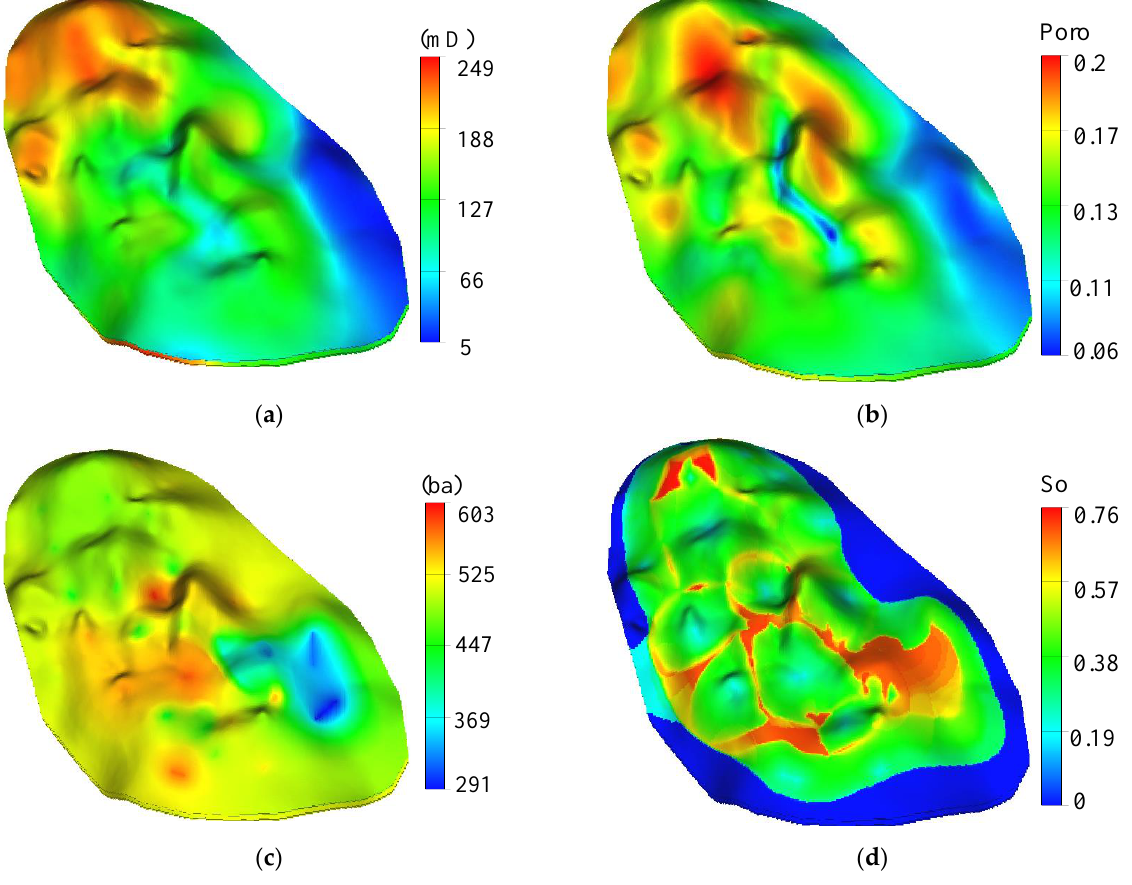
Figure 1. Basic properties of Baoshaceng reservoir: ( a ) Permeability distribution, ( b ) Porosity distri- bution, ( c ) Pressure distribution, ( d ) Oil saturation distribution.